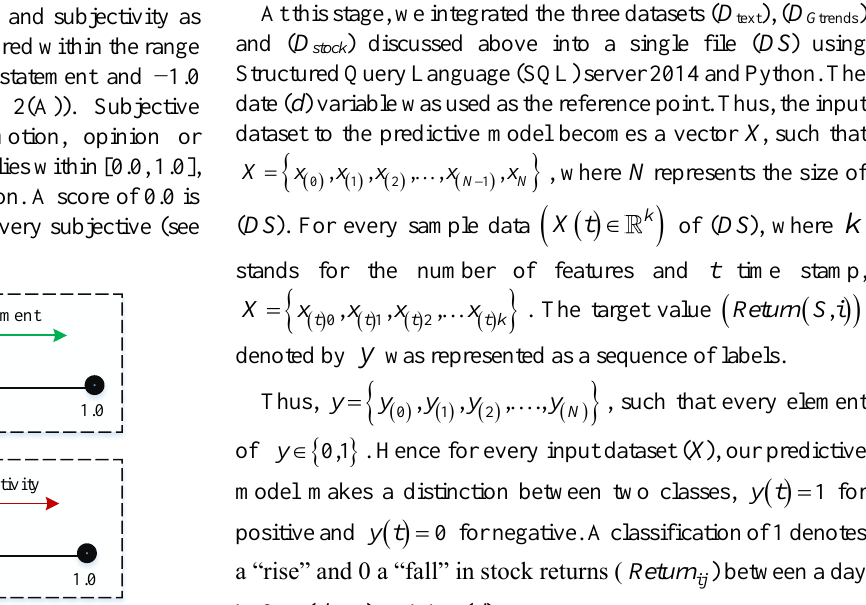
Fig. 2 Polarity and subjectivity